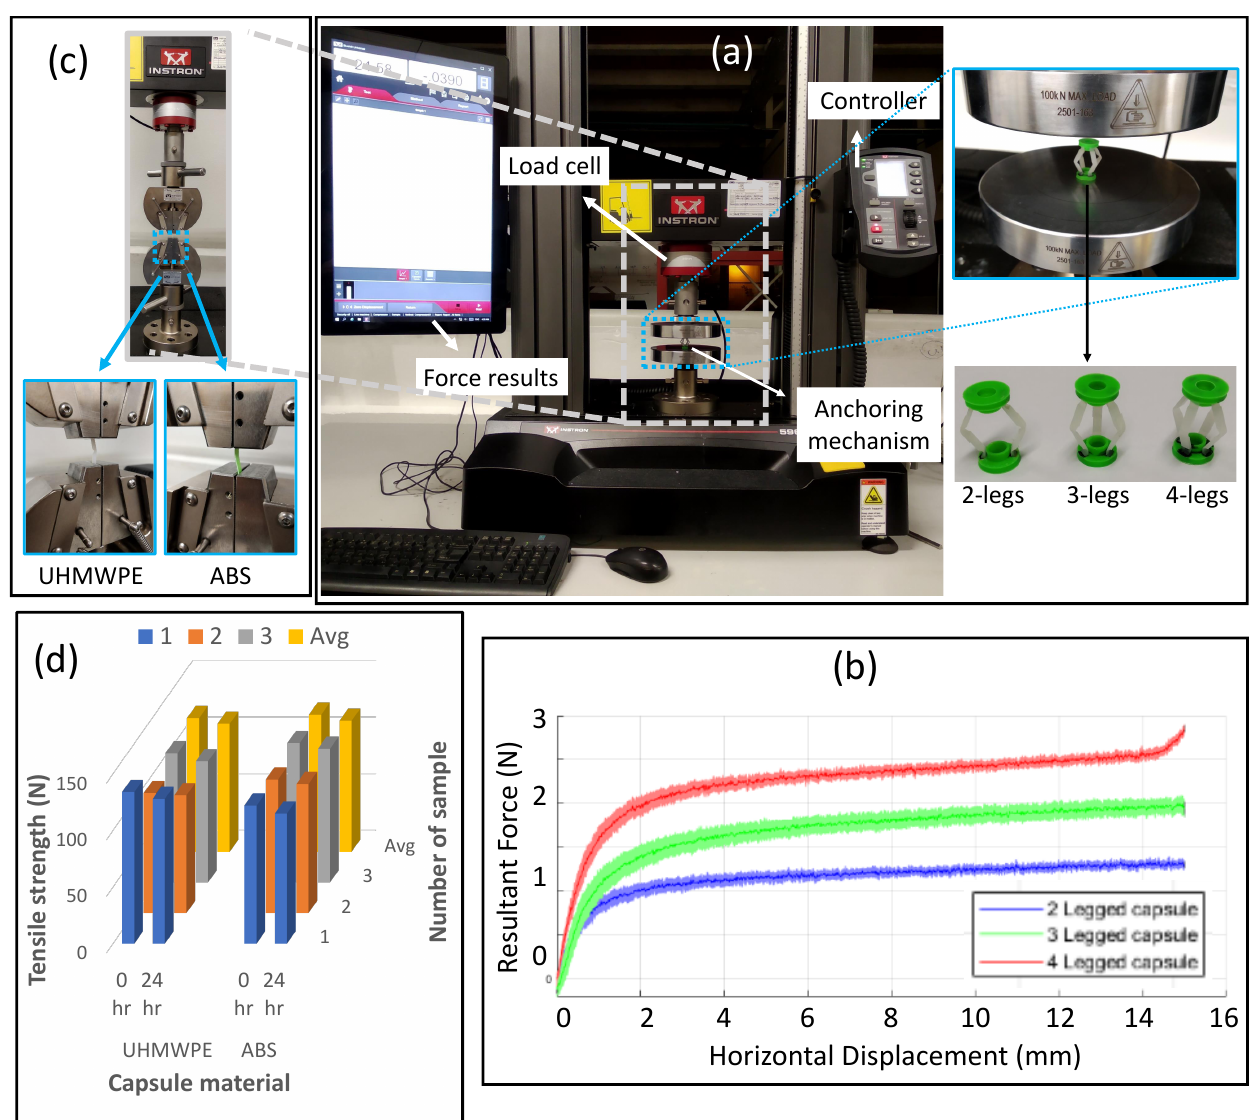
Figure 5. ( a ) Universal testing machine for measuring the compression force for each variant. ( b ) Force required to compress the end caps of the anchoring mechanism, measured by UTM. ( c ) UTM for measuring tensile strength of capsule materials (UHMWPE and ABS). ( d ) Tensile strength of material with and without exposure to stomach